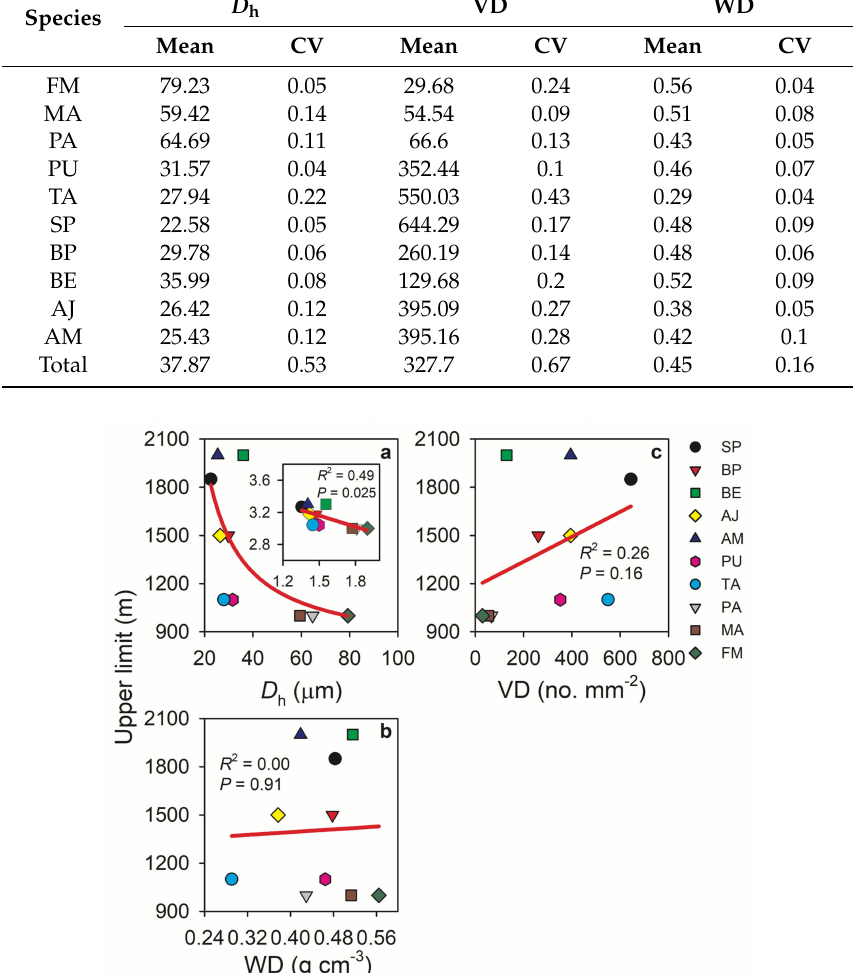
Figure 3. Relationships between upper limit UL of 10 species studied and hydraulically weighted vessel diameter D h ( a ), stem sapwood density WD ( b ), and xylem vessel density VD ( c ). In panel ( a ), the inset figure shows the same relationships on a log–log scale. Symbols show species mean values ( n = 6). AJ = Alnus japonica ; AM = Alnus mandshurica ; BE = Betula ermanii ; BP = Betula platyphylla ; FM = Fraxinus mandshurica ; MA = Maackia amurensis ; PA = Phellodendron amurense ; PU = Populus ussuriensis ; SP = Sorbus pohuashanensis ; TA = Tilia amurensis